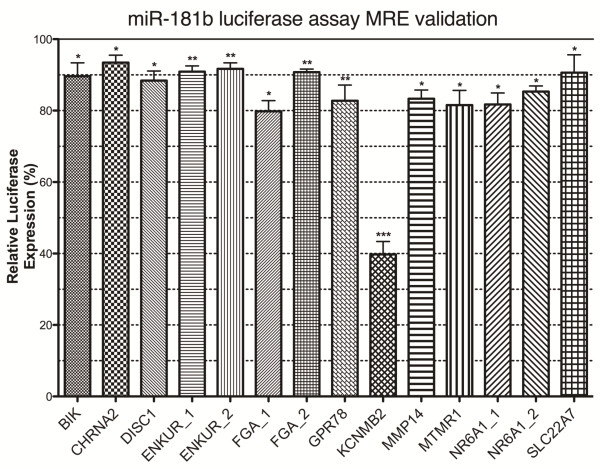
Reporter gene analysis of miRNA recognition elements (MRE). Putative MREs from genes modulated by miRNA expression were cloned into the 3′-UTR of the firefly luciferase gene in pMIR-REPORT. Responsiveness of the firefly luciferase reporter gene to increased miR-181b expression (miR-181b transfection) was analysed with respect to a pRL-TK renilla luciferase control. Data was normalised against mutant miR-181b miRNA control transfection. This data was obtained from n=4 experiments, each performed in triplicate, and analysed using a one-tailed T-test.